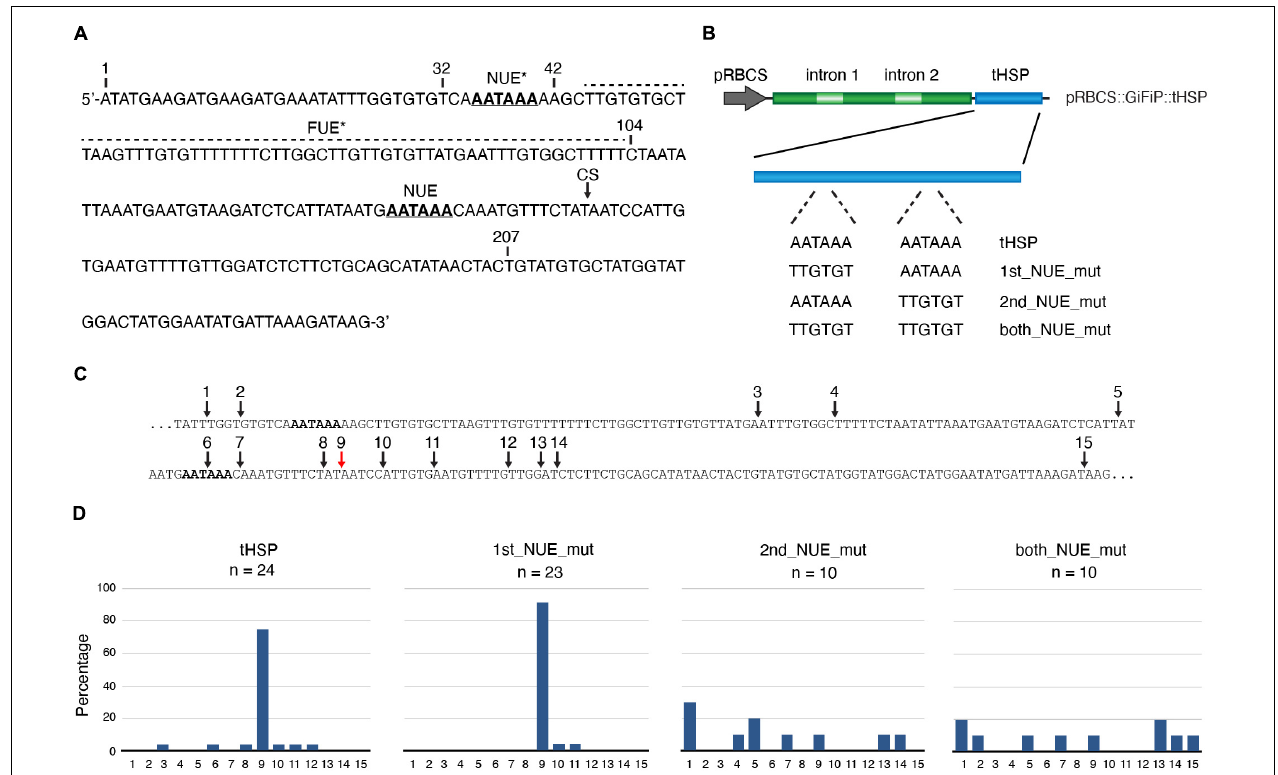
FIGURE 1 | Analysis of the tHSP poly(A) signal. (A) The sequence of the HSP18.2 terminator, with putative poly(A) signals represented in bold/underlined characters. The functional and a potential second near upstream element (NUE and NUE*, respectively) are shown. A region with characteristics compatible with a far upstream element (FUE*) is indicated by a dashed line. The black arrow points to the dominant poly(A) cleavage site (CS). Numbers indicate the nucleotide position relative to the start of the sequence, as well as regions deleted to produce the different constructs shown in Figure 2 . (B) Scheme representing the pRBCS::GiFiP::tHSP reporter and variations carrying mutations in either one or both NUEs. (C) A fragment of the tHSP sequence containing the mapped poly(A) sites indicated by numbered arrows. The expected dominant site is shown with a red arrow. (D) Graphs representing the percentage that each of the positions depicted in panel (C) was cloned. Poly(A) mapping data are from a single (2nd_NUE_mut and both_NUE_mut) or two independent experiments (tHSP and